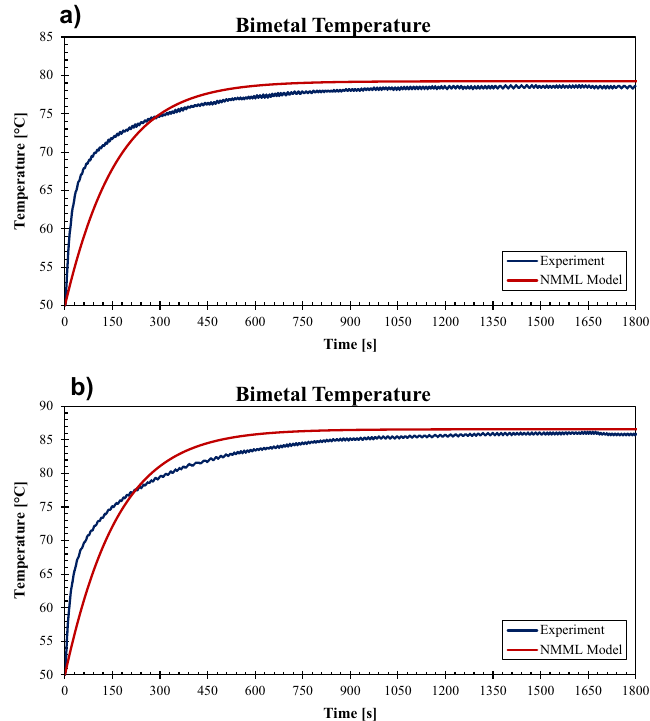
Figure 6. Bimetal temperature rise, experiment Vs. NMML model: ( a ) I = 18.8A , BM-3 , ( b ) I = 24.0A , BM-4.